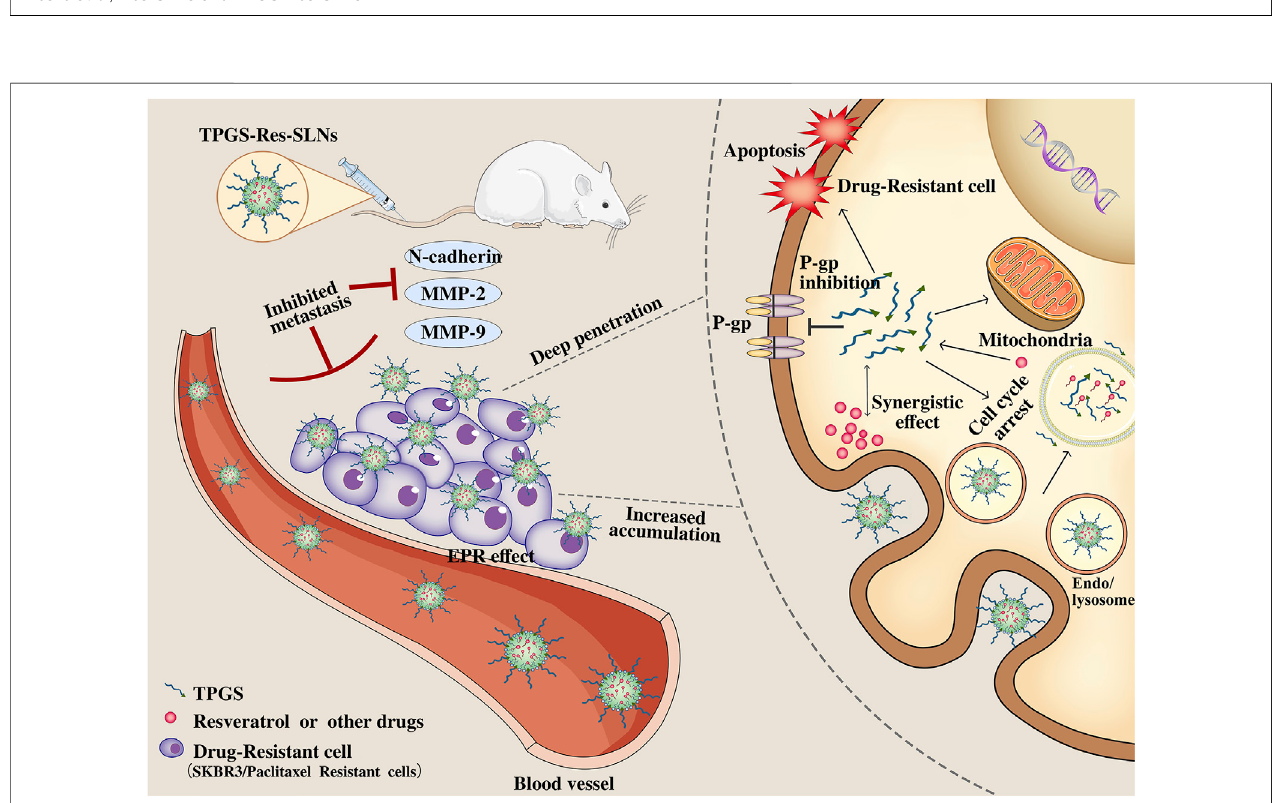
FIGURE 9 | Schematic illustration of the mechanism of TPGS-Res-SLNs regulates paclitaxel resistance in breast cancer.